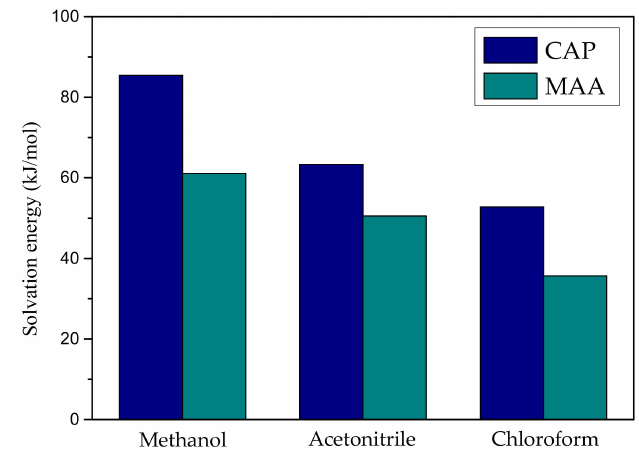
Figure 2. Solvation energy of CAP and MAA in di ff erent solvents.